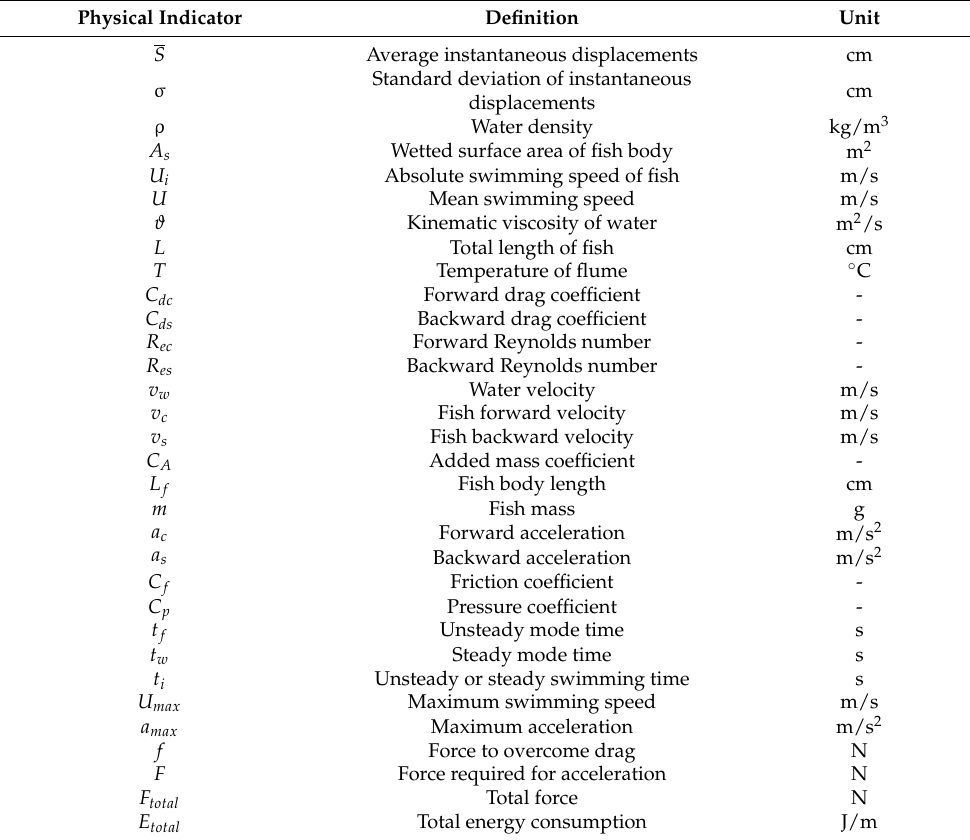
Table 2. List of symbols used in the kinematic analyses of S. malacanthus swimming. Physical